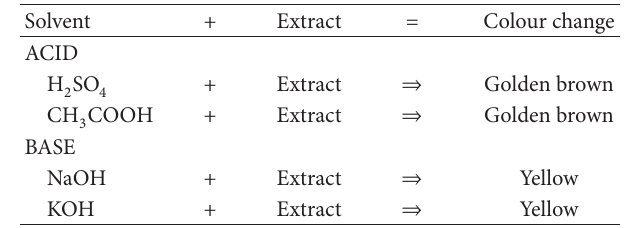
pH = 5.24. Table 3: Hibiscus extracts (methanol extract) (initial colour of extract: blood red).